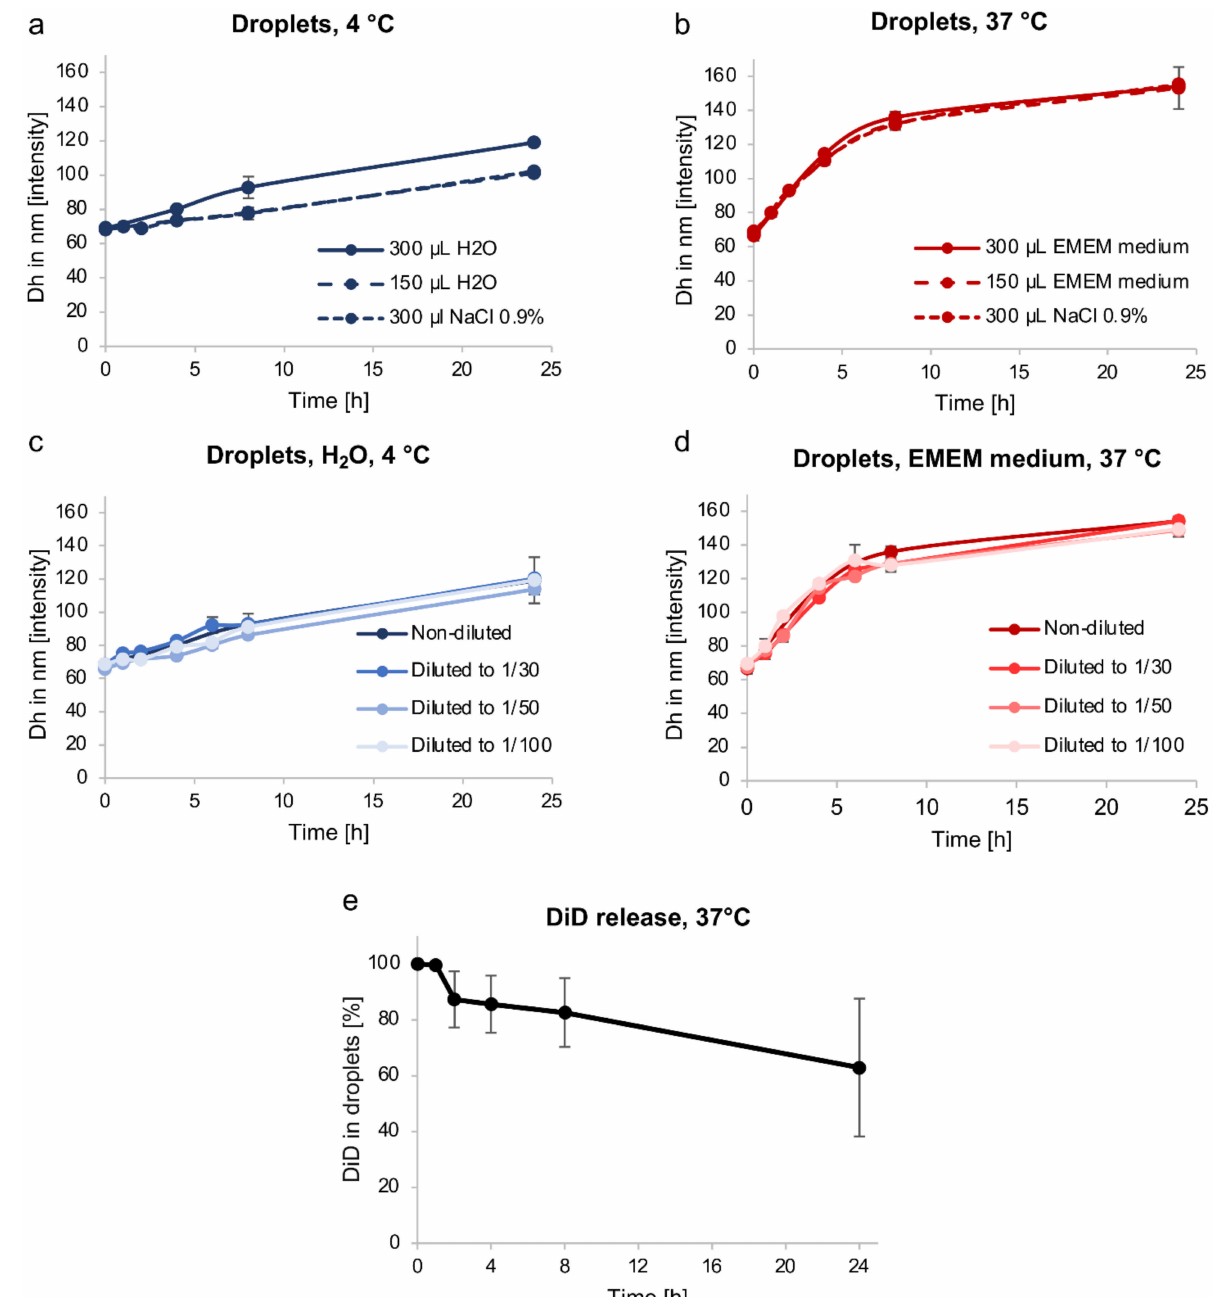
Figure 2. Stability of nanoemulsions. ( a , b ) Changes in droplet Dh over time, after rehydration with various dispersing phases (water, NaCl 0.9%, complete cell culture medium (EMEM + 10% FCS)) and volumes, and stored at 4 ◦ C ( a ) or 37 ◦ C ( b ). ( c , d ) Impact of dilution on changes in droplet Dh over time after rehydration with water at 4 ◦ C ( c ) or complete cell culture medium (EMEM + 10% FCS) at 37 ◦ C ( d ). ( e ) DiD release from STE at 37 ◦ C over time, HPLC dosage. The values are reported as mean ± SD ( n =